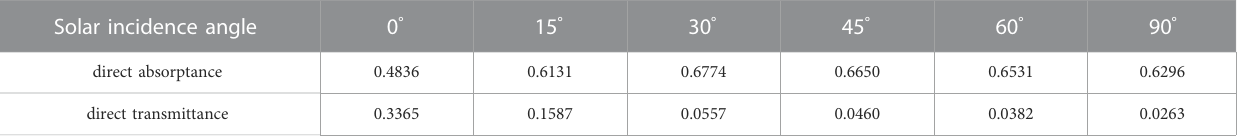
TABLE 4 Summary of direct absorptance and direct transmittance, for different solar incidence angles.